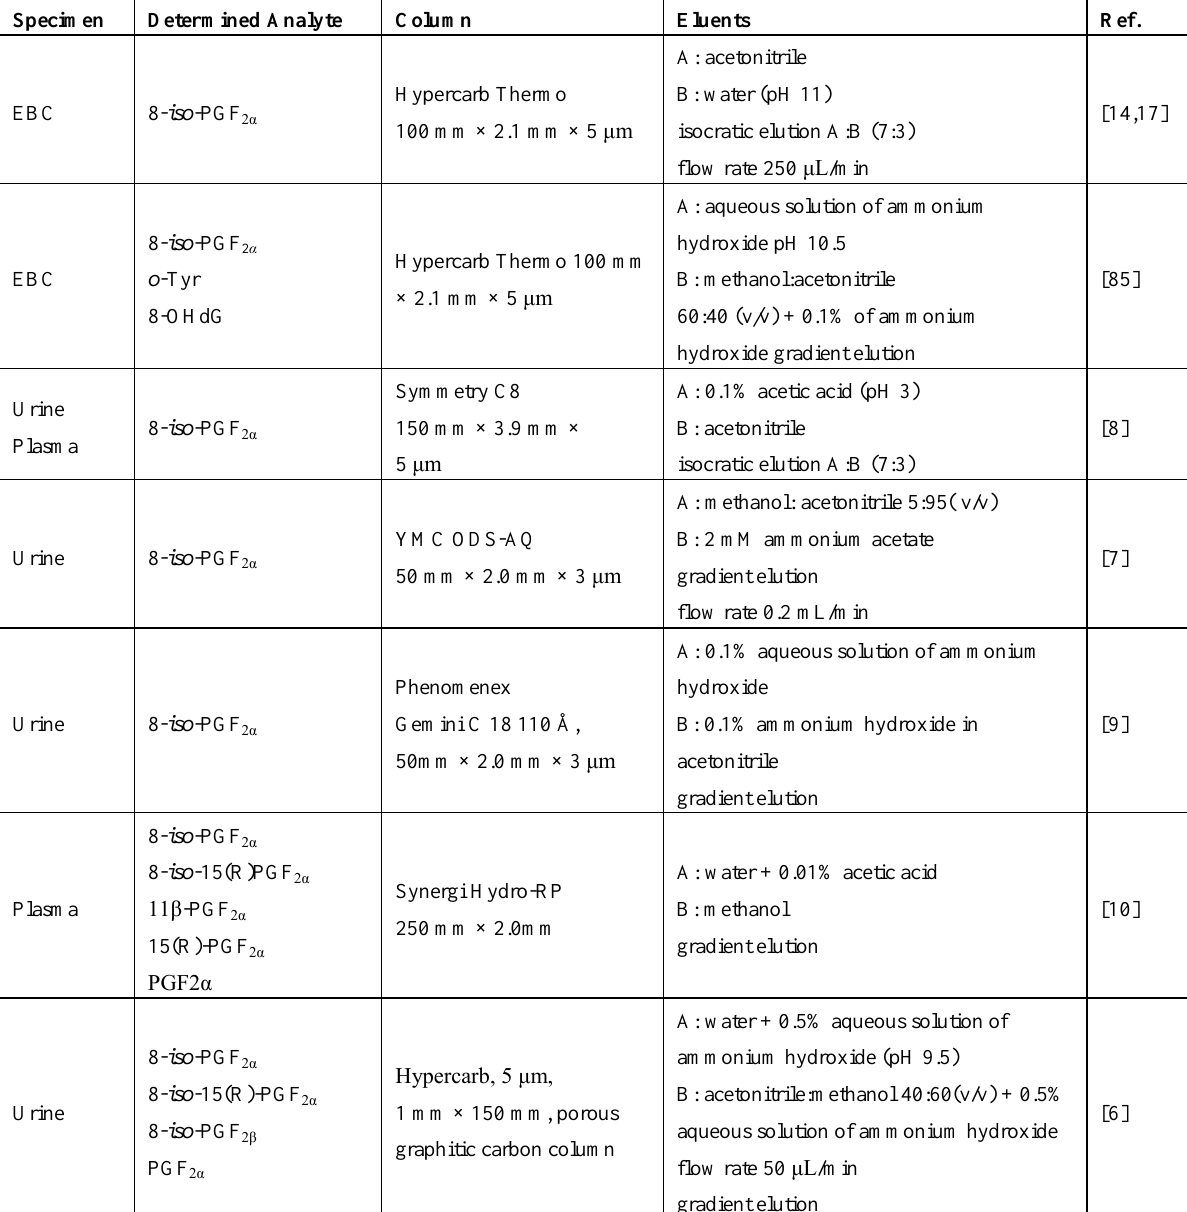
Table 3. Chromatographic parameters in the analysis of biological samples for isoprostanes‘